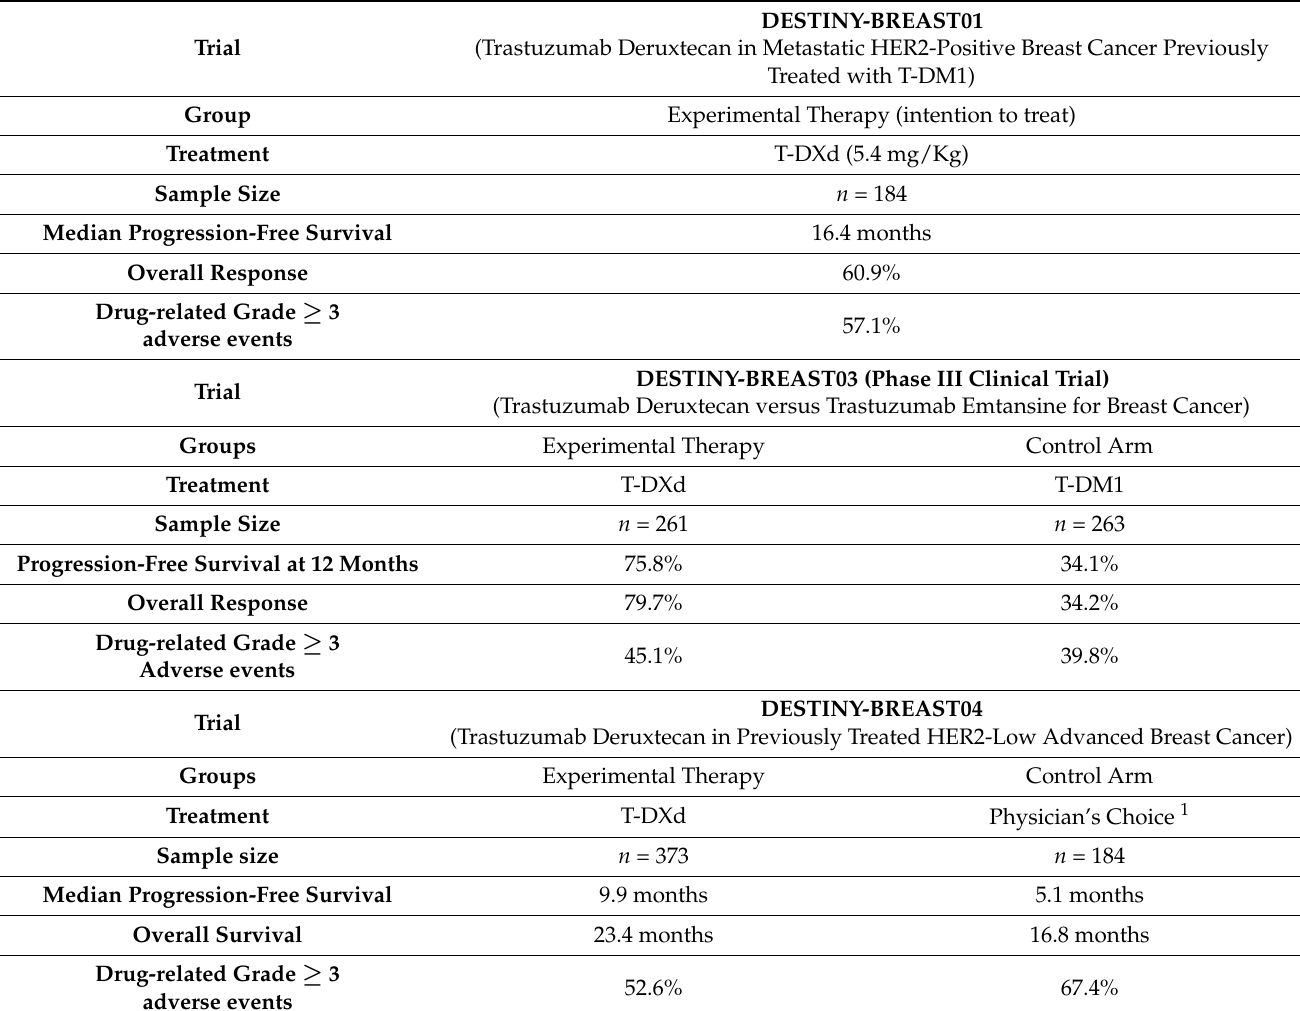
Table 4. Summary of clinical trials that led to FDA approval of